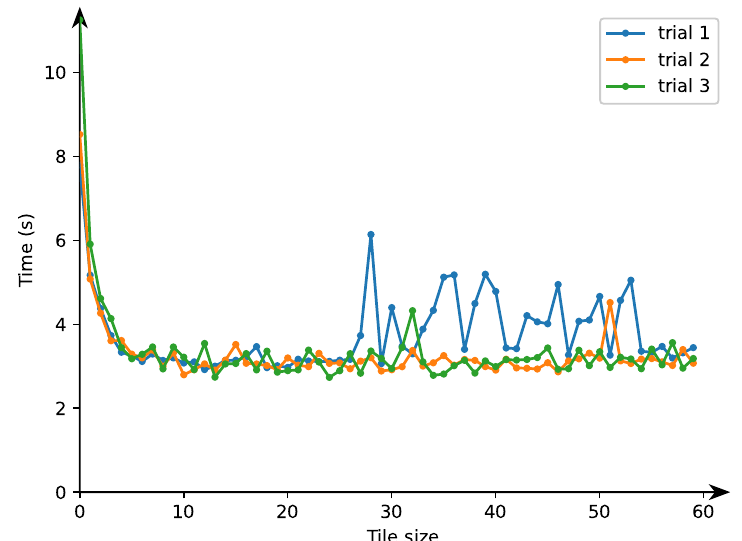
Figure 1. Time for different tile sizes. All